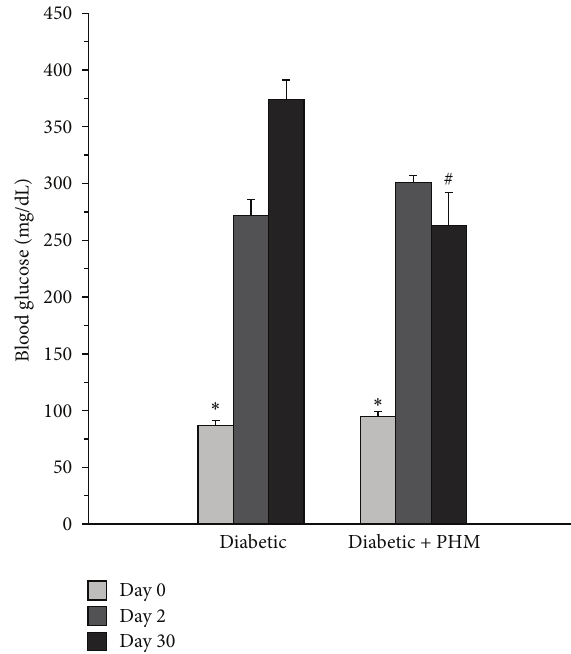
Figure1:Effectsofthepolyherbalmixture(PHM)onbloodglucose. The animals in group of diabetic + PHM received PHM for 4 weeks. ∗ 𝑃 < 0.01 compared with day 2 and day 30 at the corresponding group. # 𝑃 < 0.01 comparedwiththecorrespondingvalueindiabetic control group. The data are expressed as mean ± SEM for eight (diabetic + PHM) or six (normal and diabetic control)